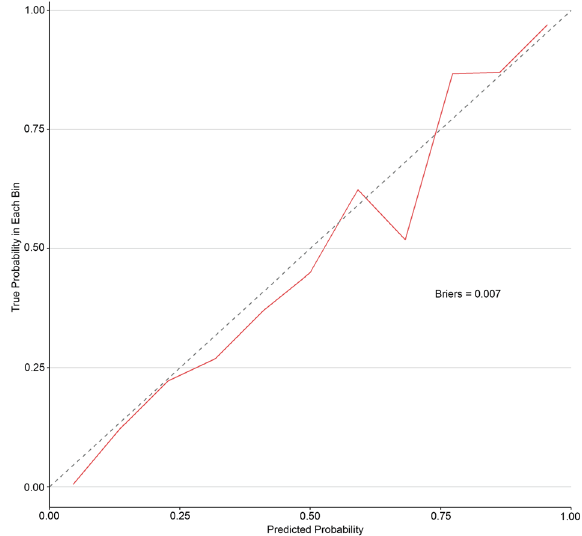
Fig. 1 Test data accuracy, Receiver Operator Curve (ROC) curve with Area Under the Curve (AUC) measure of performance for all classi fi cation thresholds. The red line is the ROC curve, and the grey line represents the diagonal y = x and a point where the curve is random.